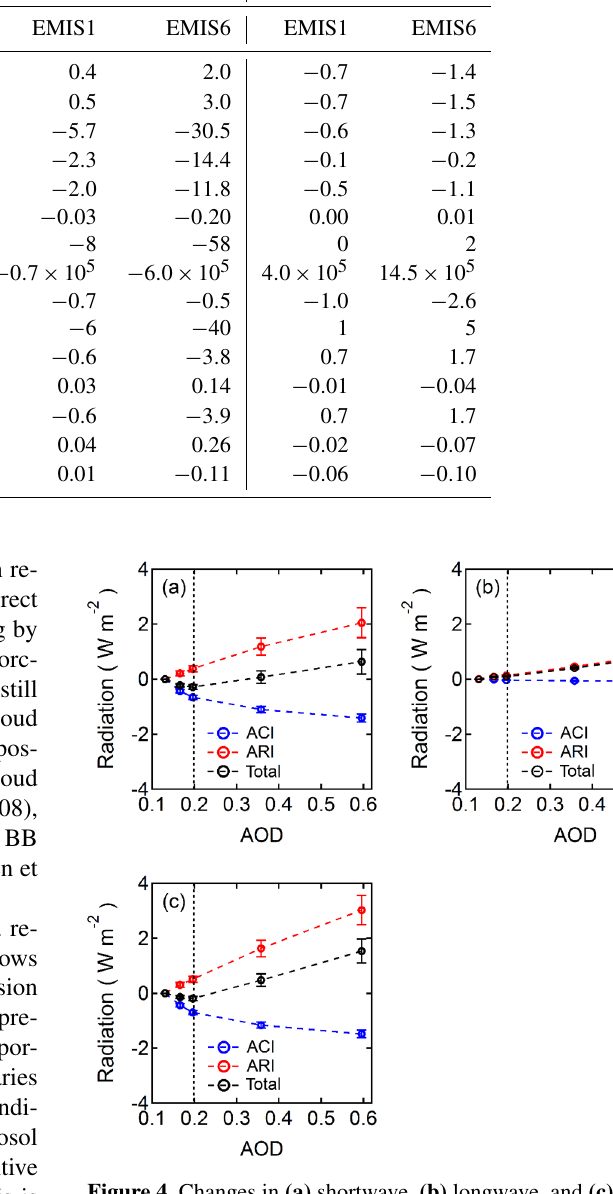
Table 3. Summary of monthly mean perturbations caused by the ARI and ACI of BB aerosols in the EMIS1 and EMIS6 emission scenarios. Variable ARI